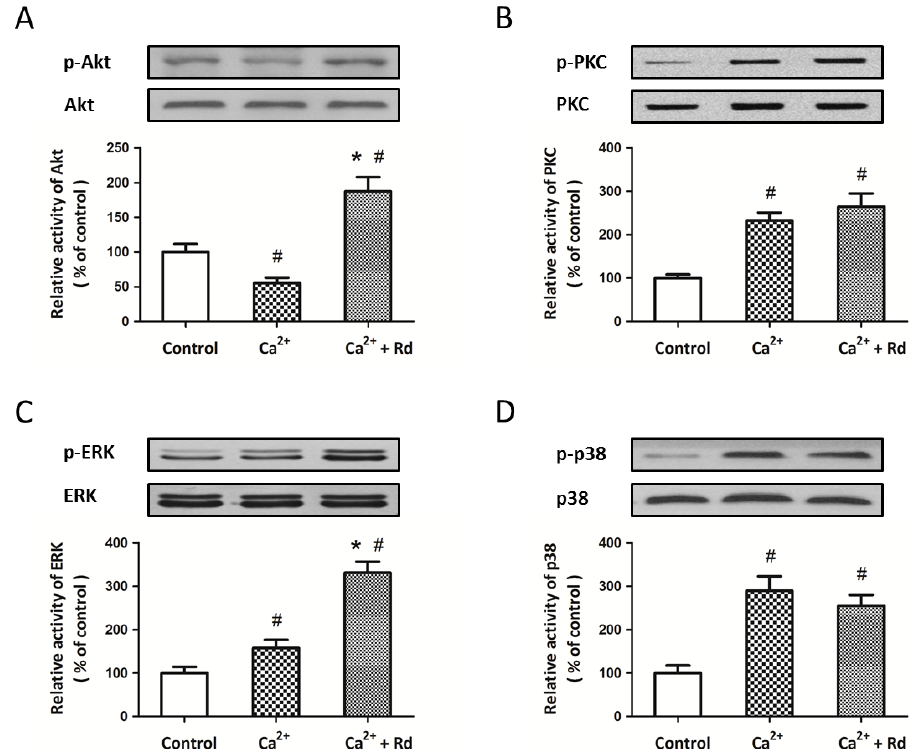
Figure 4. Effects of Rd on the phosphorylation of mitochondrial protein kinases after Ca 2+ treatment in isolated spinal cord mitochondria. Isolated spinal cord mitochondria (0.5 mg protein/mL supported by succinate) were pretreated with 10 μM Rd for 10 min before the incubation with 30 μM Ca 2+ . The activation of Akt ( A ); PKC ( B ); ERK ( C ) and p38 ( D ) were detected by Western blotting analysis. The results were represented as the percentage of control. The data were represented as means ± SD from five experiments. # p < 0.05 vs. control. * p < 0.05 vs. Ca 2+